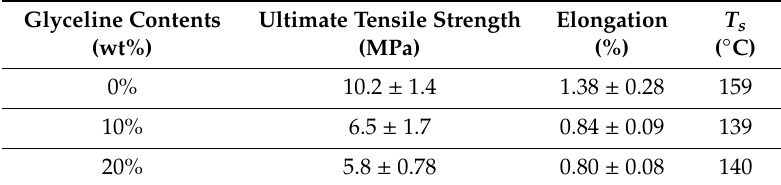
Table 1. Tensile strength and elongation for zein samples with di ff erent Glyceline contents.